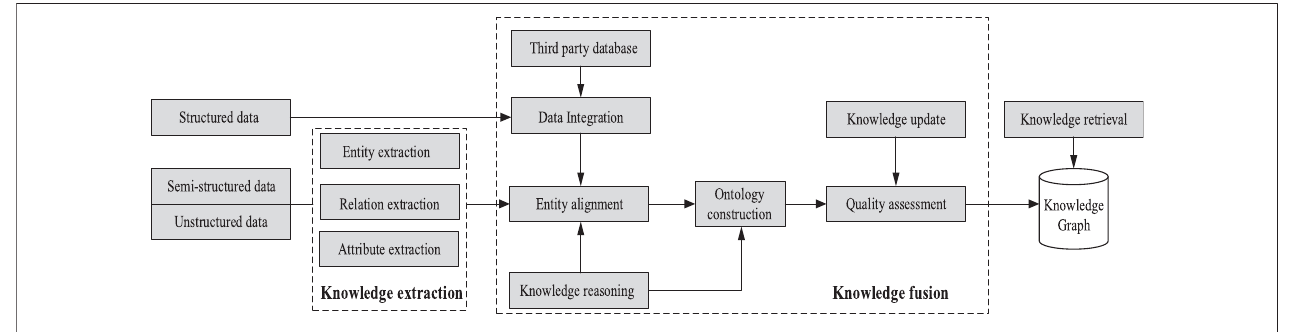
FIGURE 1 | Knowledge graph construction process.